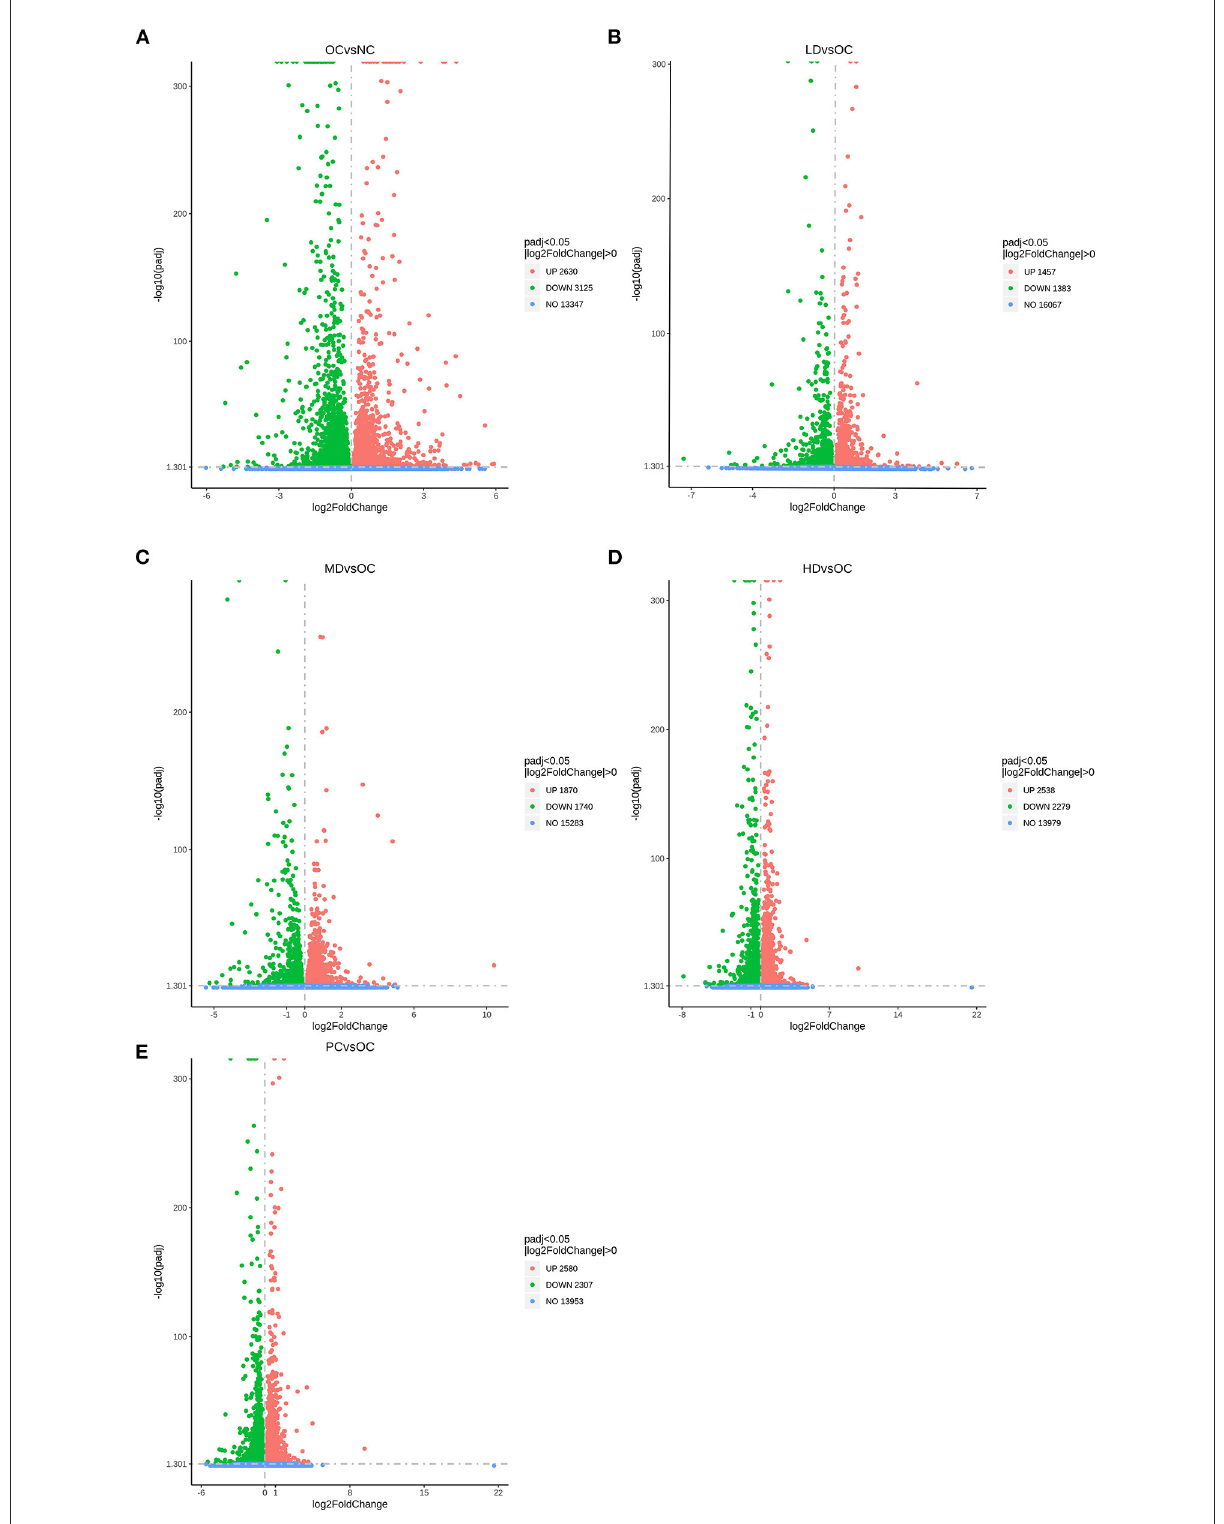
FIGURE4 Differential expressed genes displayed by volcano plot (A) OC vs. NC (B) LD vs. OC (C) MD vs. OC (D) HD vs. OC (E) PC vs. OC. The dashed blue line represents the threshold line of differential gene screening